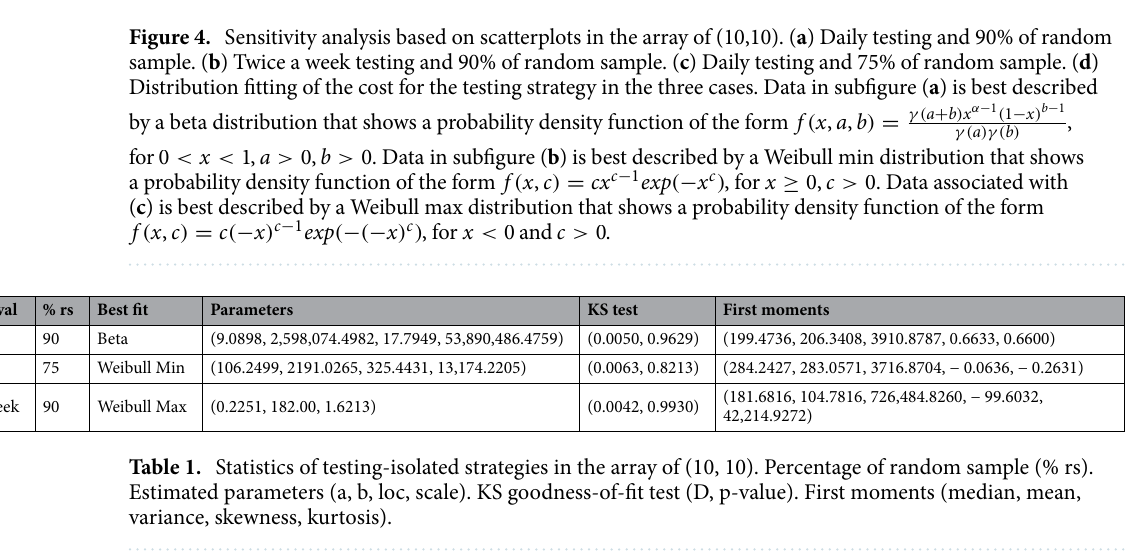
+ b ) x α − 1 ( 1 − x ) b − 1 γ( a )γ( b ) ,